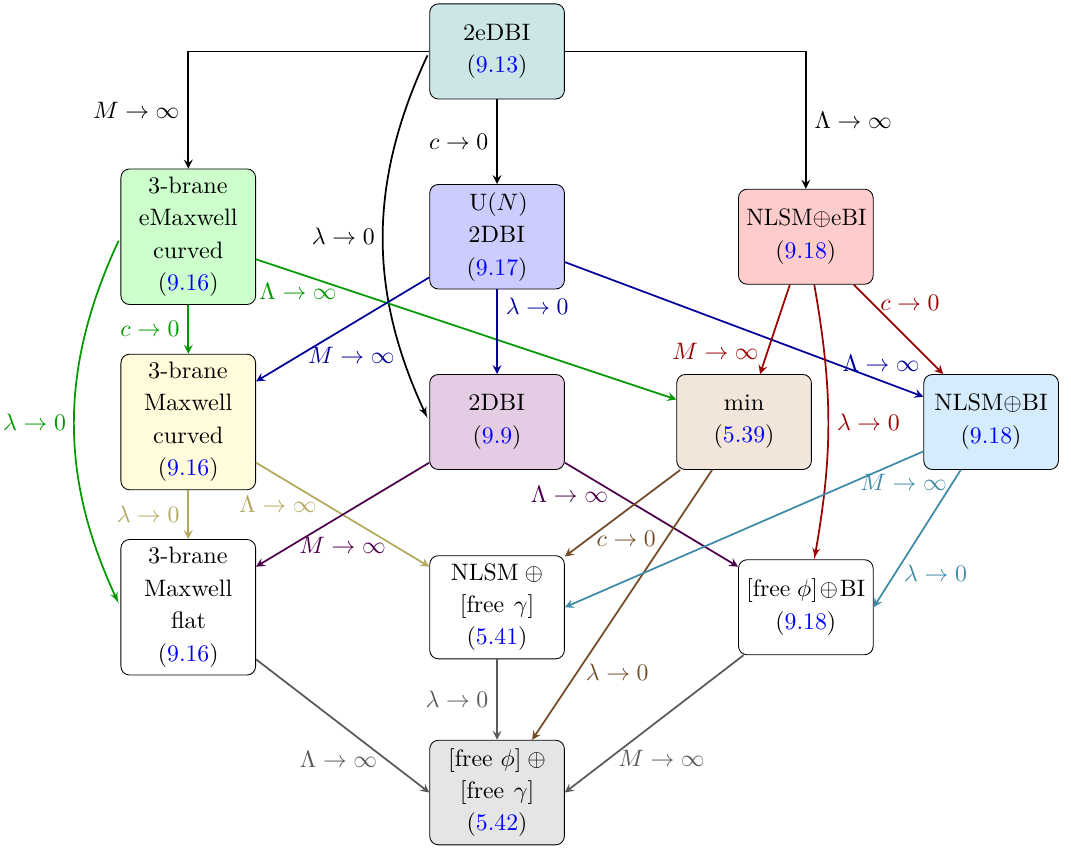
Figure 6 . Web of limits for the 2-scale extended DBI